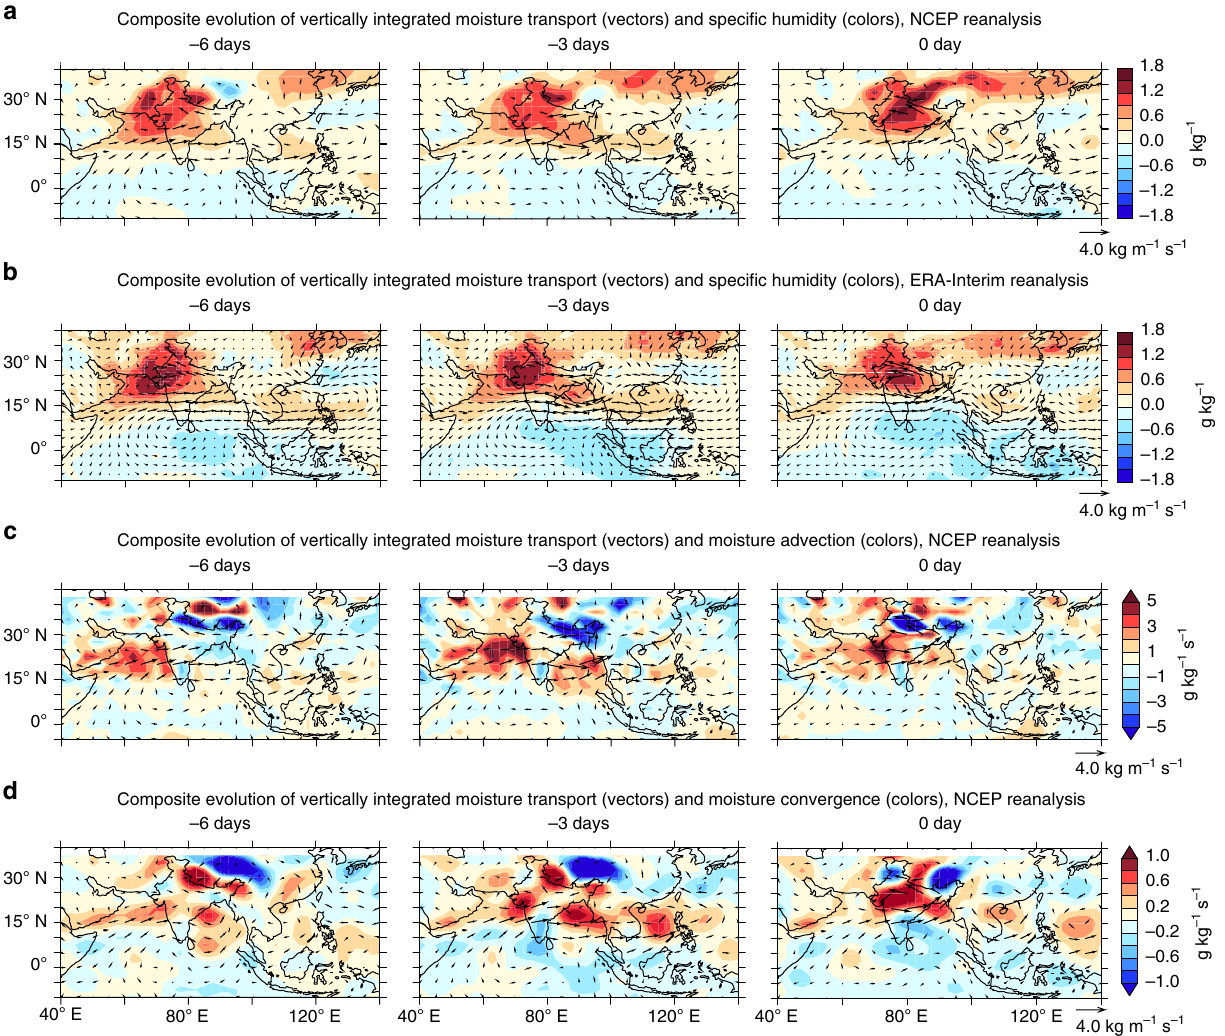
Fig. 2 Evolution of moisture transport leading to widespread extreme precipitation events. Composite evolution of moisture transport (kg m − 1 s − 1 , vectors) and a , b speci fi c humidity (g kg − 1 , colors), c moisture advection (10 − 6 g kg − 1 s − 1 , colors) and d moisture convergence (10 − 5 g kg − 1 s − 1 , colors), leading to widespread extreme precipitation events (more than ten grid cells with daily rainfall ≥ 150 mm) over central India (on 0-day). Daily data for the period 1982 – 2015 is used for the composite analysis, based on NCEP ( a , c , d ) and ERA-Interim reanalysis ( b ). The analysis is for vertically integrated (1000 –